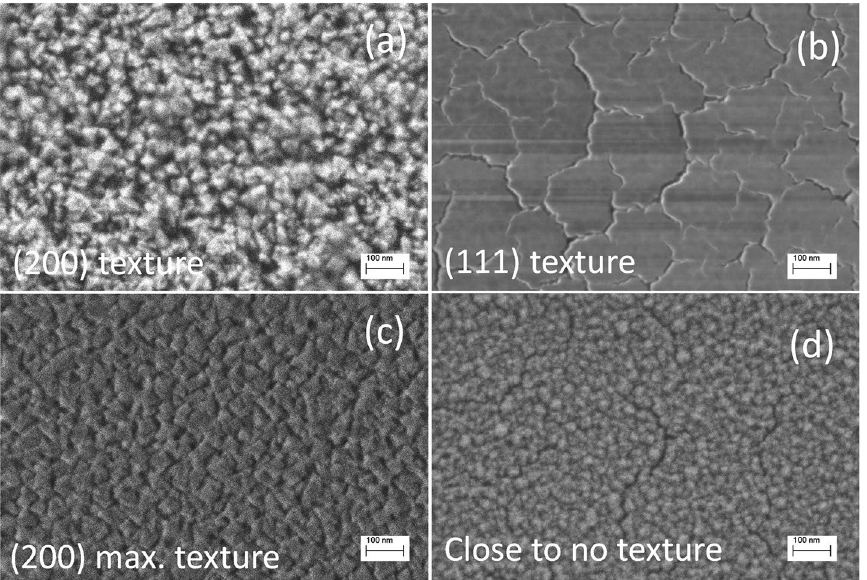
Figure 2. SEM micrographs of the ( a ) 0.03-HF-475, ( b ) 0.03-HF-425, ( c ) 0.02-HF-475, and ( d ) 0.03-LF-475